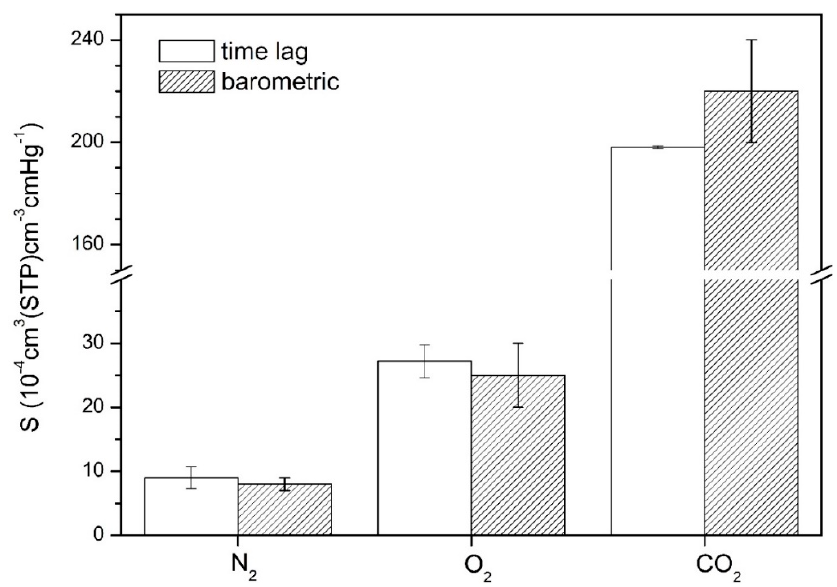
Figure 10. Solubility coefficients for N 2 , O 2 , and CO 2 (average ± SD) obtained for the test membrane by the time lag method (orange) and the barometric method (blue).